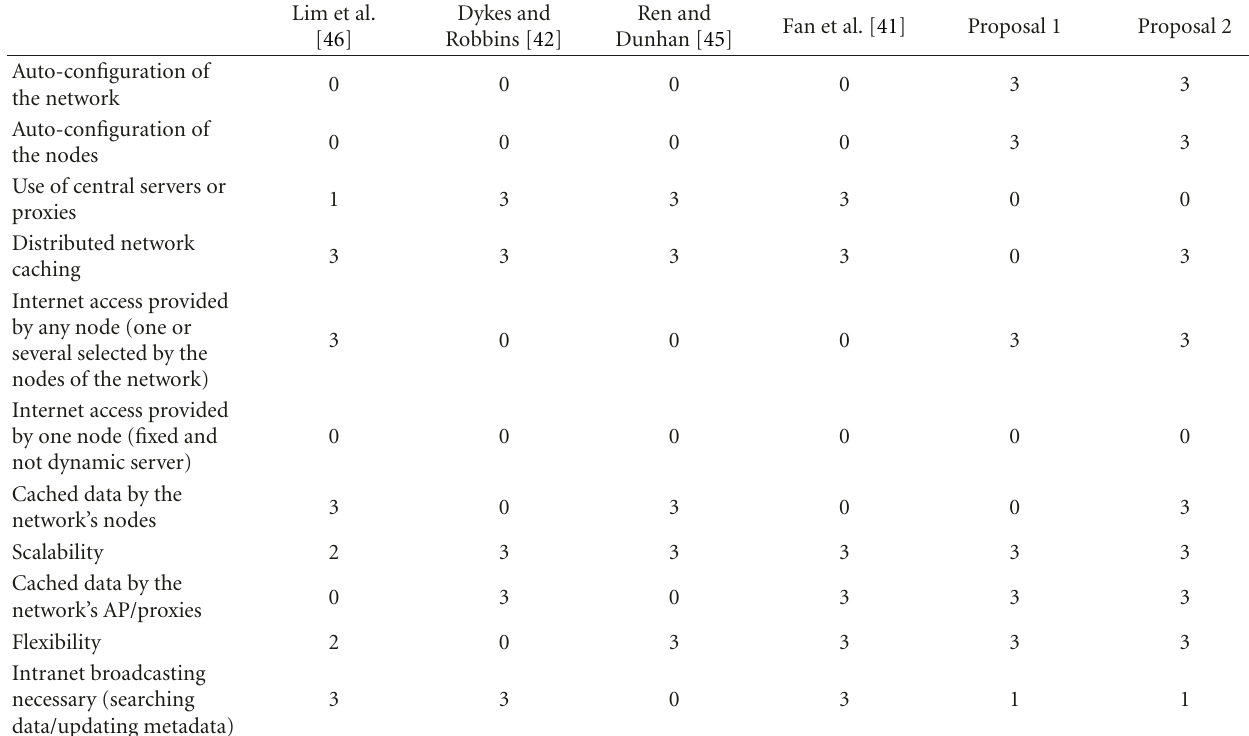
Table 1: Comparison between cache